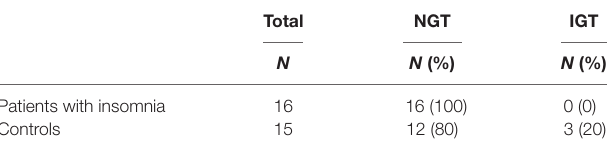
TaBle 5 | Frequency of patients with normal glucose tolerance (NGT) and impaired glucose tolerance (IGT).